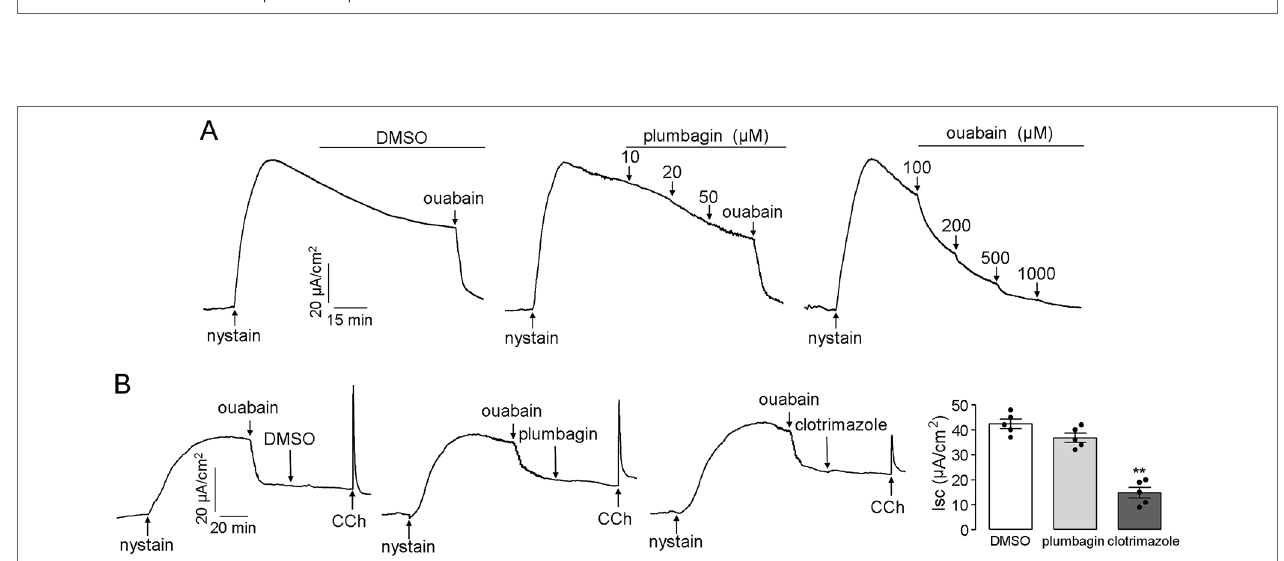
FIGURE 3 | Inhibitory effects of plumbagin on CFTR Cl ˉ channel activity. (A) Short-circuit measurements showing plumbagin and CFTR inh -172 inhibition of the CFTR Cl ˉ current in HT-29 cells following stimulation by FSK (10 μM) (n = 3). (B) Inhibition of the short-circuit current in HT-29 cells in which plumbagin was added first to the basolateral bathing solution and then to the apical bathing solution, as indicated, following stimulation by 10 μM FSK. (C) Effects of plumbagin on the CFTR Cl ˉ currents induced by different agonists. Plumbagin was added to the apical side following CFTR activation by FSK (10 μM) plus IBMX (100 μM), CPT-cAMP (100 μM), or genistein (50 μM). CFTR inh -172 (20 μM) was added to the apical bathing solution to inhibit the remaining the CFTR current (n = 3). (D) Effects of plumbagin on CFTR Cl ˉ current in mouse colon. The indicated concentrations of plumbagin and CFTR inh -172 were added to the mucosal surface. Representative current traces are shown as one of three independent